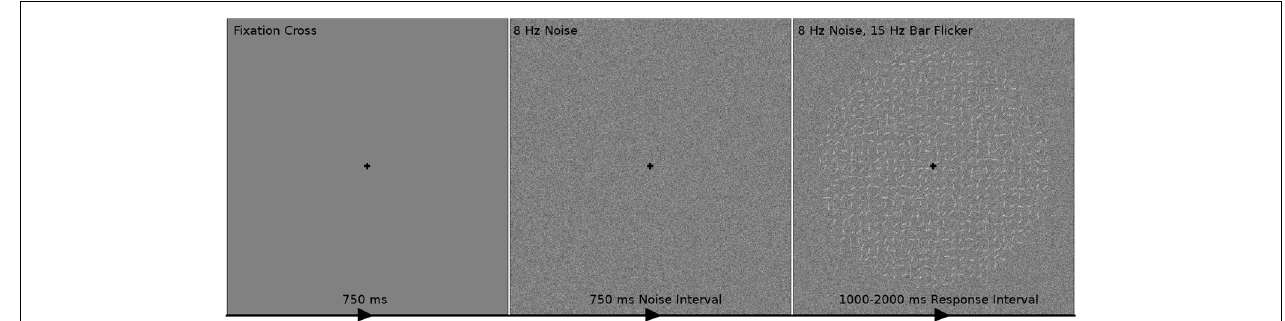
FIGURE 2 | The time course of one trial of the experimental stimulus. The participant first fixated on a black cross for 750ms indicating the beginning of a trial. The participant then observed visual contrast noise changing at 8Hz for 750ms while maintaining fixation. A circular field of small oriented bars flickering at 15 Hz overlaid on the changing visual noise was then shown to the participant for 1000–2000ms. The task was to indicate